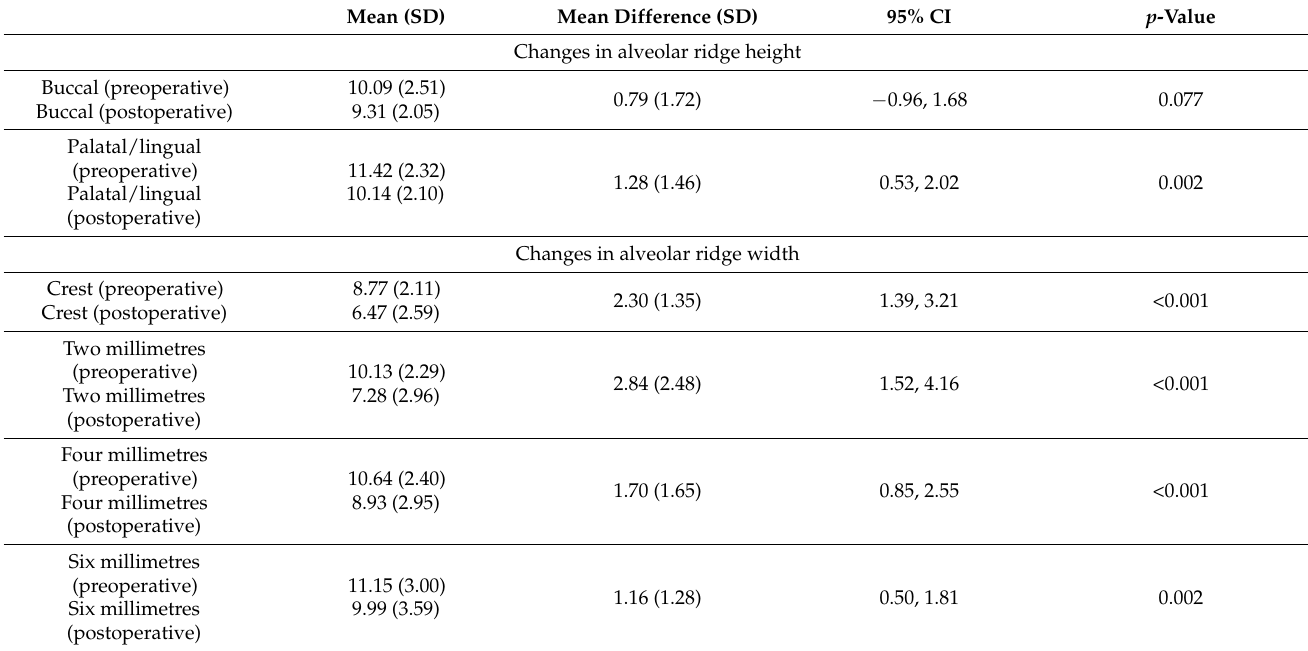
Table 2. Preoperative and Postoperative mean changes in alveolar ridge height and